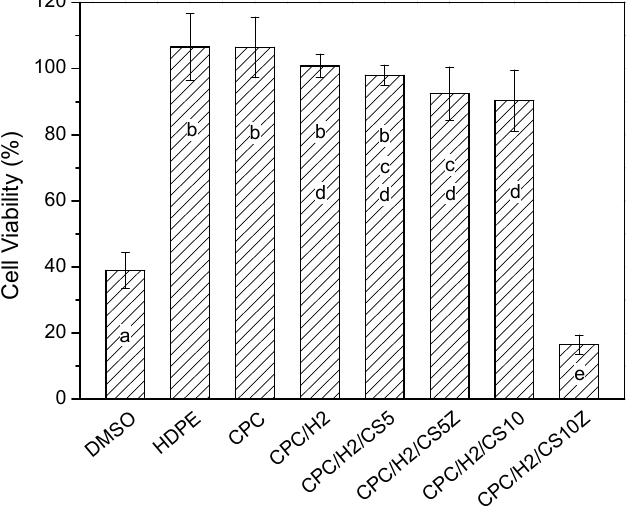
Figure 8. The relative cell viabilities (%) of CPC, CPC/H2, CPC/H2/CS5, CPC/H2/CS5Z, CPC/H2/CS10 and CPC/H2/CS10Z compare with HDPE (positive control group), DMSO (negative control group), and a blank group (as 100% cell viability) obtained in 24 h cultures. The data in the same statistical level was marked with the same letter (a, b, c, d, and e) on the